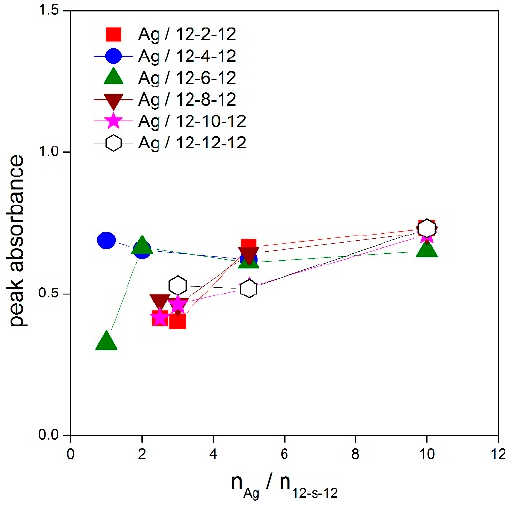
Figure 4. Dependence of peak absorbance on molar ratio n Ag /n 12- s -12 for silver nanoparticles stabilized with gemini surfactants 12- s -12.